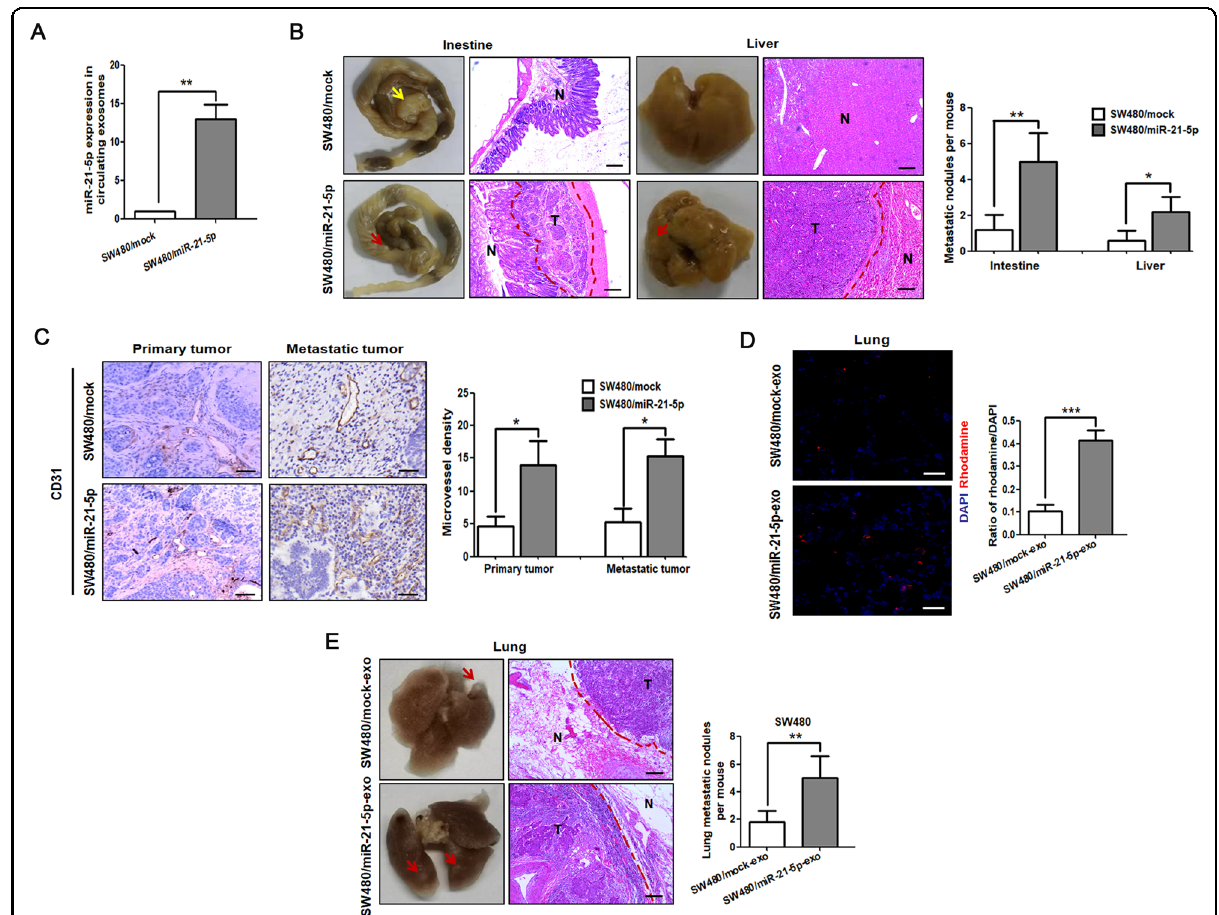
Fig. 3 CRC-secreted exosomal miR-21-5p induces angiogenesis and vascular permeability in vivo. A Expression of miR-21-5p in circulating exosomes extracted from the serum of mice bearing SW480/mock or SW480/miR-21-5p tumors. Mean ± SEM are provided ( n = 5 mice per group). B Intestinal and hepatic metastatic nodules after SW480/mock or SW480/miR-21-5p cells were injected in the cecal mesentery of nude mice for two months. Yellow arrow points at primary tumor, while red arrows point at metastatic nodules. Metastatic tumor tissues (T) and normal tissues (N) were observed. Scale bars represent 100 µm. The number of intestinal and hepatic metastatic nodules per mouse was counted under the microscope. Mean ± SEM are provided ( n = 5 mice per group). C Introtumoral microvessel density in primary and metastatic tumors after SW480/mock or SW480/ miR-21-5p cells were injected in the cecal mesentery of nude mice for two months. The number of microvessels was counted under the microscope (labeled by CD31). Scale bars represent 50 µm. Mean ± SEM are provided ( n = 5 mice per group). D Effect of SW480/mock exosomes and SW480/miR- 21-5p exosomes on vascular permeability of lung in nude mice to rhodamine-dextran by in vivo vascular permeability assay. Rhodamine-dextran was injected into the tail vein of nude mice pre-treated with SW480/mock exosomes or SW480/miR-21-5p exosomes. Levels of rhodamine-dextran fl uorescence in tissues were quanti fi ed using Image J software and normalized to the levels of DAPI. Scale bars represent 50 µm. Mean ± SEM are provided ( n = 5 mice per group). E SW480 were injected into the tail vein of nude mice pre-treated with SW480/mock exosomes or SW480/miR-21- 5p exosomes. Red arrows point at lung metastatic nodules. Metastatic tumor tissues (T) and normal tissues (N) were observed. Scale bars represent 100 µm. The number of lung metastatic nodules per mouse was counted under the microscope. Mean ± SEM are provided ( n = 5 mice per group). * P < 0.05, ** P < 0.01, *** P <